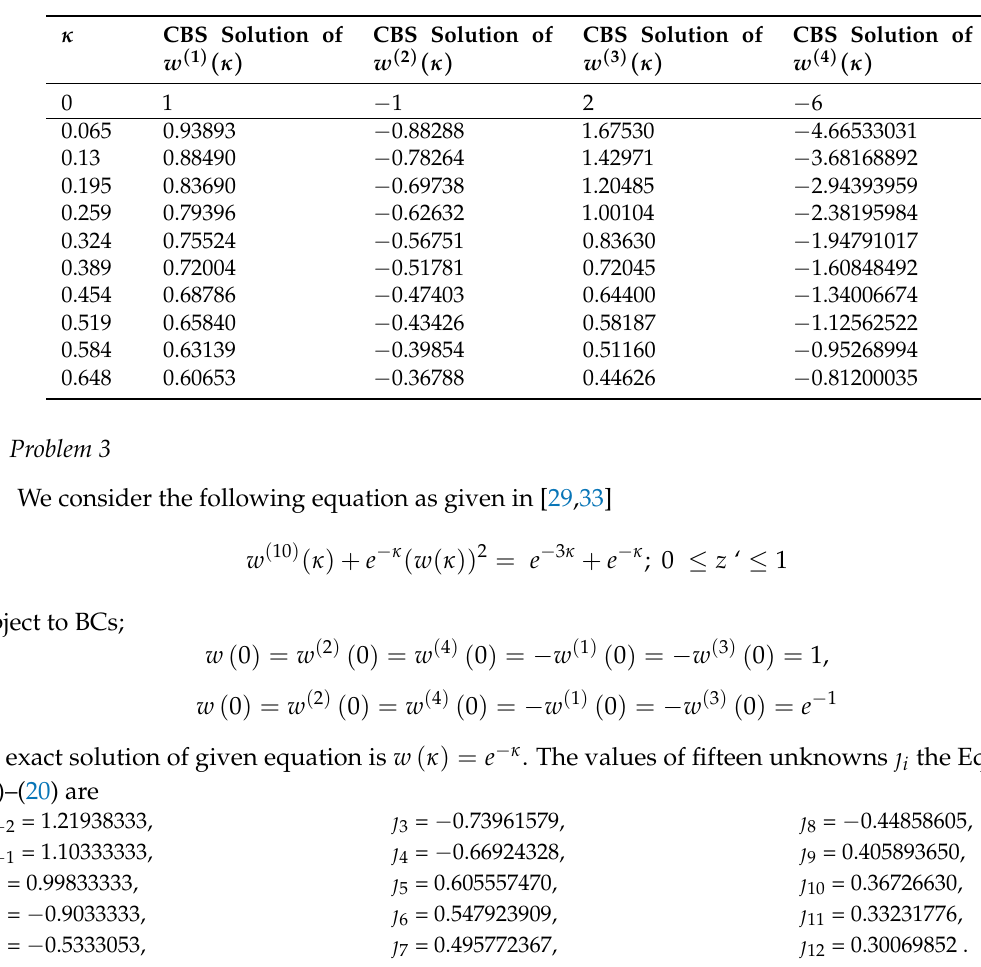
Table 7. Errors at derivatives where BCs are defined in problem 2 at h = 0.064872.